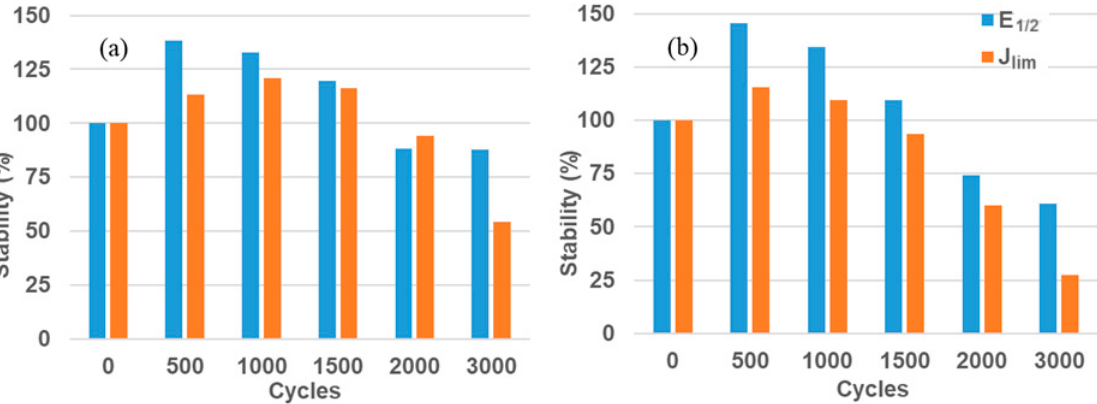
Figure 6. Evolution of the stability of the catalytic activity parameters (E 1/2 and J lim ) of ( a ) PtCo/MWCNT 6 and ( b ) PtCo/MWCNT 4.